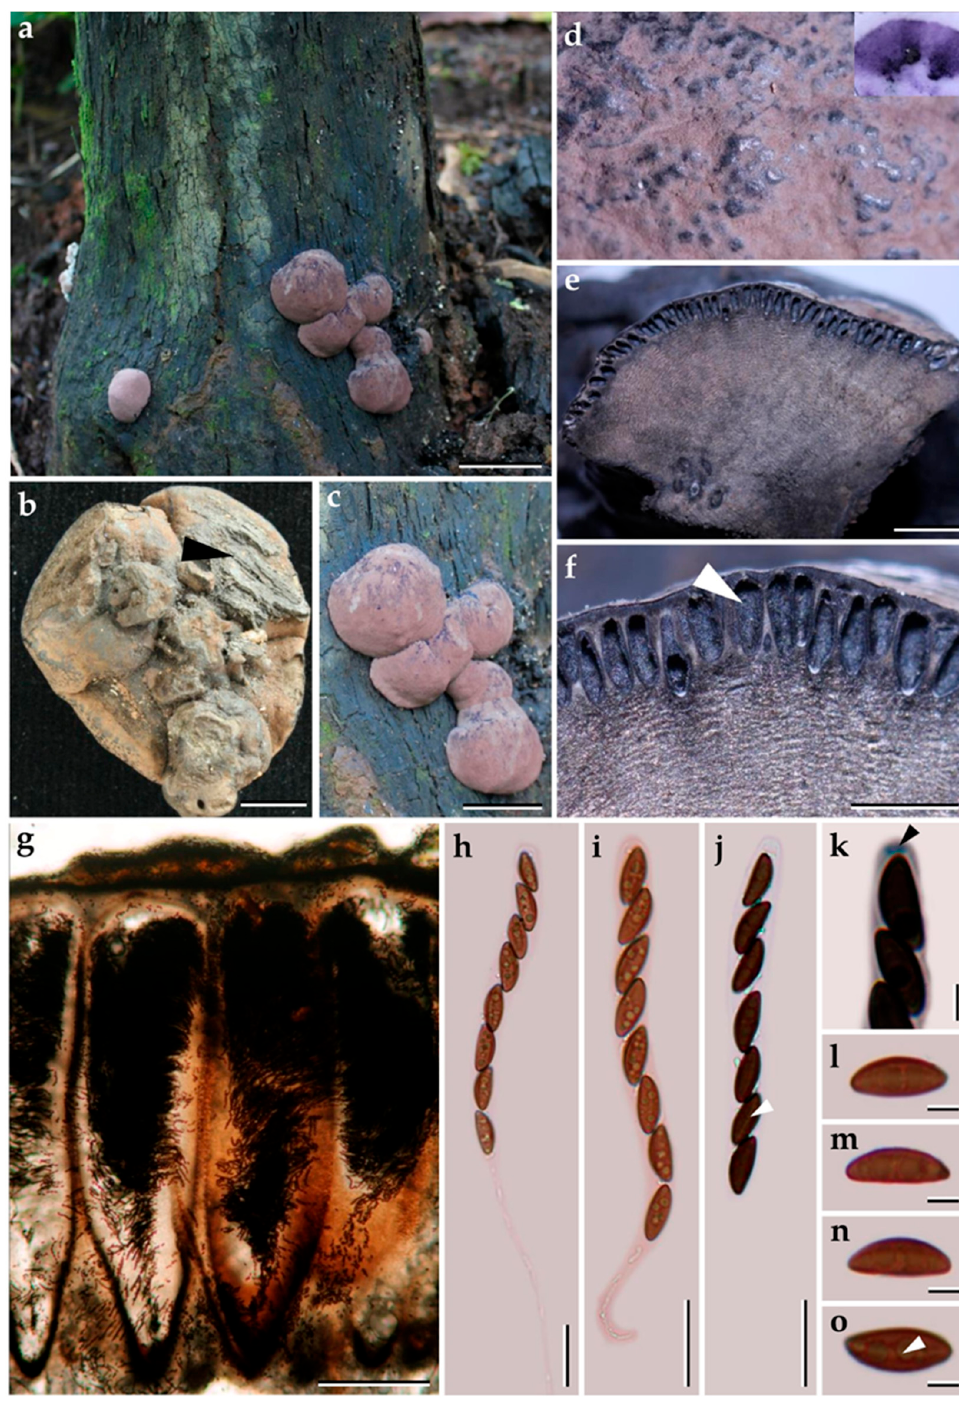
Figure 2. Morphological characteristics of Pyrenopolyporus laminosus from Thailand (BBH47928). ( a , c ) Stromata with natural substrate; ( b ) detail of stromal insertion point; ( d ) stromal surface and ostioles with KOH-extractable pigments in 10% KOH; ( e ) longitudinal section of the stroma showing perithecia and the tissue below the perithecial layer; ( f ) Perithecia (white arrow); ( g ) Perithecia under light microscope; ( h – j ) asci; ( k ) apical apparatus, bluing in Melzer’s reagent (black arrow); ( l – n ) ascospores. ( o ) Ascospore showing germ slit (white arrow); scale bars: ( a , c ) = 5 cm; ( b ) = 0.5 cm; ( e ) = 5 mm; ( f ) = 1 mm; (g) = 0.25 mm; ( h – j ) = 20 µm; ( k – o ) = 5 µm.